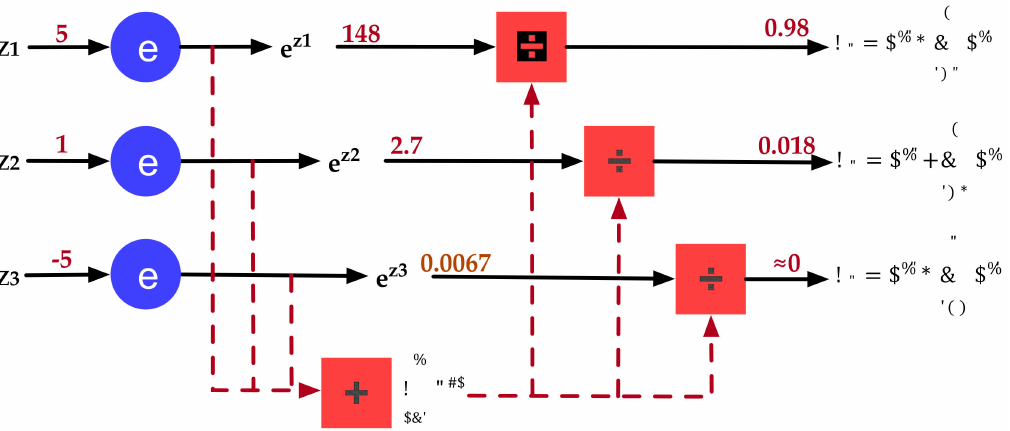
Figure 6. Softmax operation